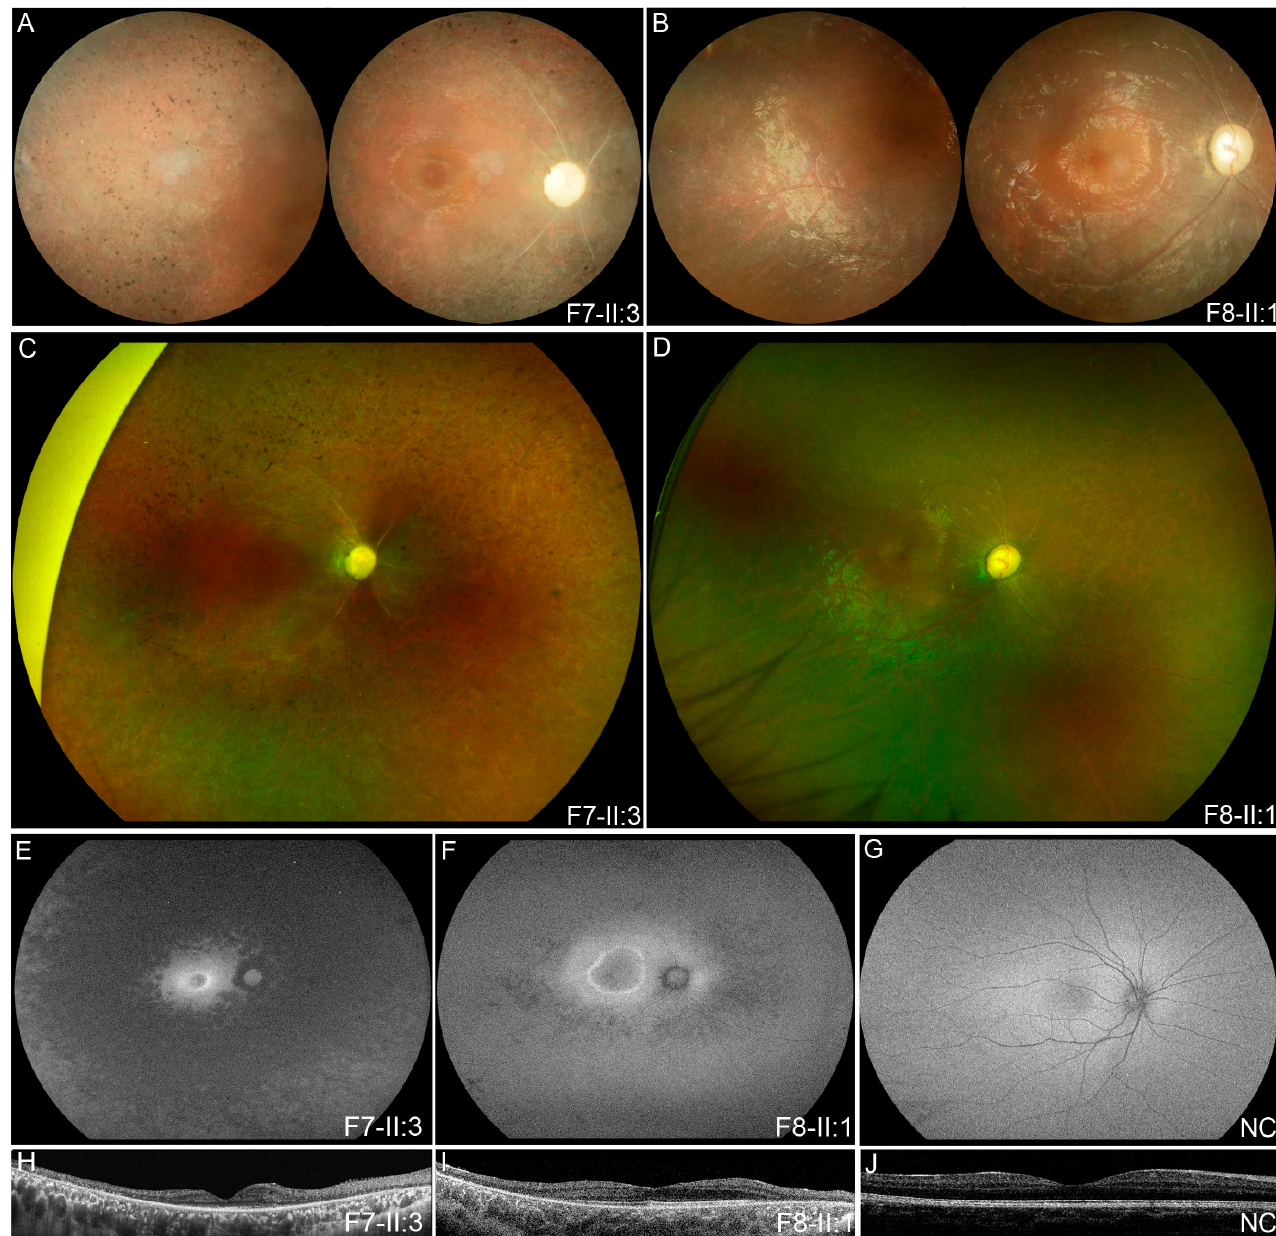
Figure 3. Multimodal fundal images of two probands with EOSRD. Complete optic disc pallor, sil- ver wiring of retinal vessels, and salt-and-pepper retinal degeneration mostly in the mid-peripheral area was observed in color fundus photographs ( A ) and SLO image ( C ) of patient F7-II:3. His FAF image ( E ) indicated hypoauto fl uorescence outside the vascular arcades and hyperauto fl uorescent ring in the central macula. Signi fi cant retinal thinning was observed in the OCT image ( H ). In patient F8-II:1, complete optic disc pallor, silver wiring of retinal vessels, and generalized tapetoretinal de- generation was observed in his color fundus photographs ( B ) and SLO image ( D ). Macular involve- ment was observed in the color fundus photograph, while a hyperauto fl uorescent ring around the macula and speckled hypoauto fl uorescence in the mid-peripheral area was observed in FAF image ( F ). OCT ( I ) revealed disruptions of the interdigitation and ellipsoid zones, a shallow foveal pit, and remarkably reduced retinal thickness. ( G , J ) were FAF image and OCT result of a normal control. EOSRD, early-onset retinal dystrophy; SLO, scanning laser ophthalmoscopy; OCT optical coherence tomography; FAF, fundus auto fl uorescence; NC, normal control.